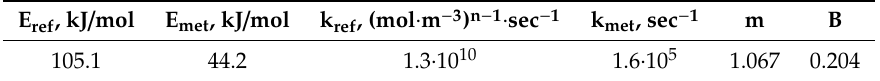
Table 2. The values of B, m, E Langmuir–Hinshelwood model.